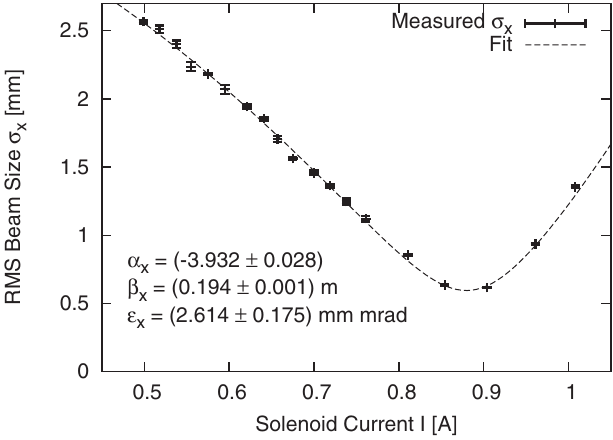
FIG. 3. Solenoid scan data and fit in the horizontal plane. The derived results have been calculated at the solenoid entry